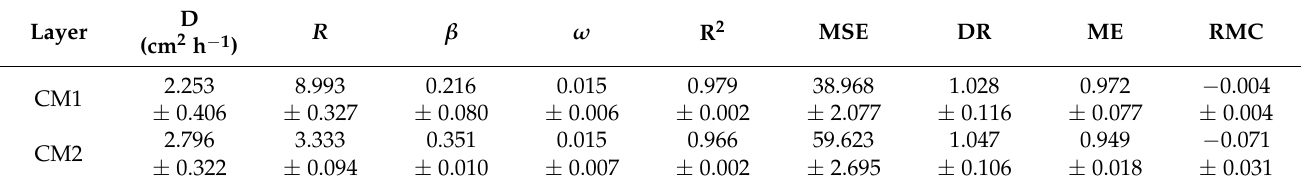
Table 7. Estimated values of parameters, determination coefficient R 2 and MSE, DR, ME, and RMC statistical criteria for the two-site model for CM1 and